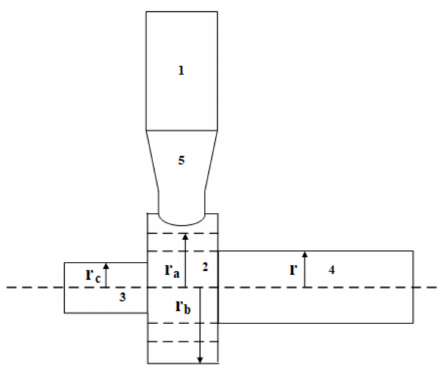
Figure 1. Schematic diagram of the coaxial input